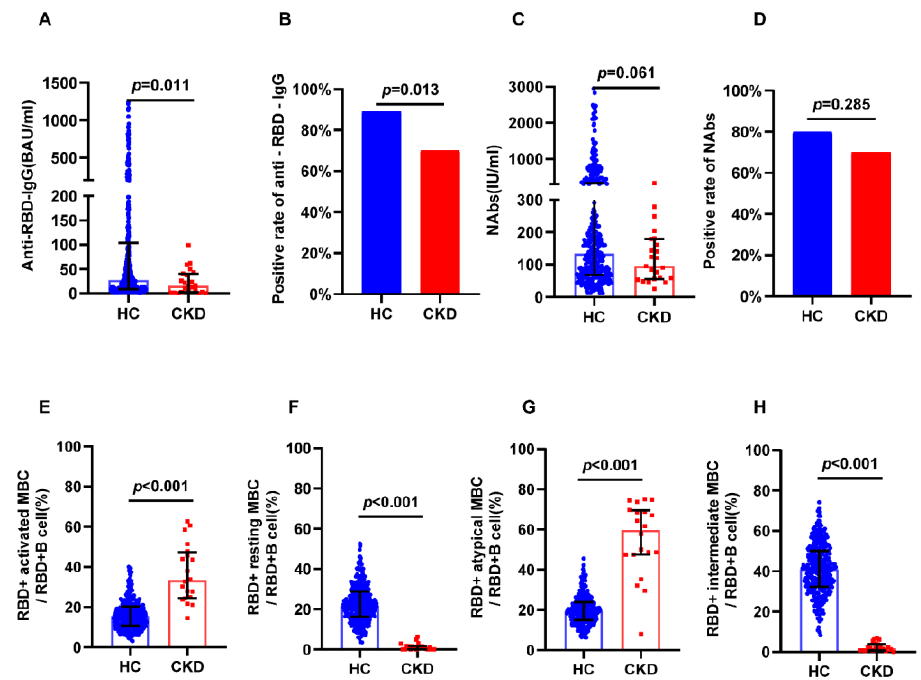
Figure 4. Humoral immune responses following immunization with vaccines in dialysis CKD patients and all healthy controls. ( A ) The serum anti-RBD-IgG levels. ( B ) The seropositivity rates of anti-RBD-IgG. ( C ) The serum NAbs levels. ( D ) The seropositivity rates of Nabs. ( E ) The frequency (percentage of RBD-specific B cells) of RBD-specific activated MBCs. ( F ) The frequency (percentage of RBD-specific B cells) of RBD-specific resting MBCs. ( G ) The frequency (percentage of RBD-specific B cells) of RBD-specific atypical MBCs. ( H ) The frequency (percentage of RBD-specific B cells) of RBD-specific intermediate MBCs. The IQR are indicated by error bars. anti-RBD-IgG, spike receptor-binding domain IgG antibody; CKD chronic renal disease; HC healthy controls; IQR interquartile range; MBCs memory B cells; NAbs neutralizing antibodies.